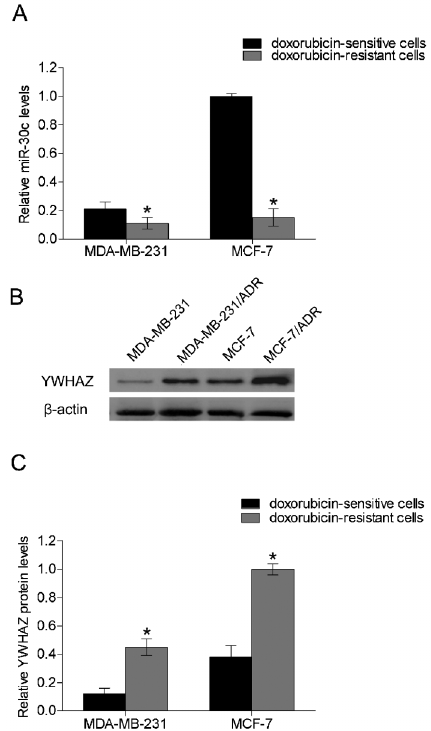
Figure 1. Down-regulation of miR-30c correlated with over- expression of YWHAZ in breast doxorubicin-resistance cells. A , qRT-PCR analysis of miR-30c expression in breast doxorubicin (ADR)-resistant and doxorubicin-sensitive cells. Data are shown as fold-changes of miRNA levels in MCF-7/ADR cell line relative to MCF-7 cell line, or in MDA-MB-231/ADR cell line relative to MDA-MB-231. *P , 0.05, Student t -test. B and C , Expression levels of YWHAZ in breast doxorubicin-sensitive and doxorubicin- resistant cell lines. *P , 0.05, Student t